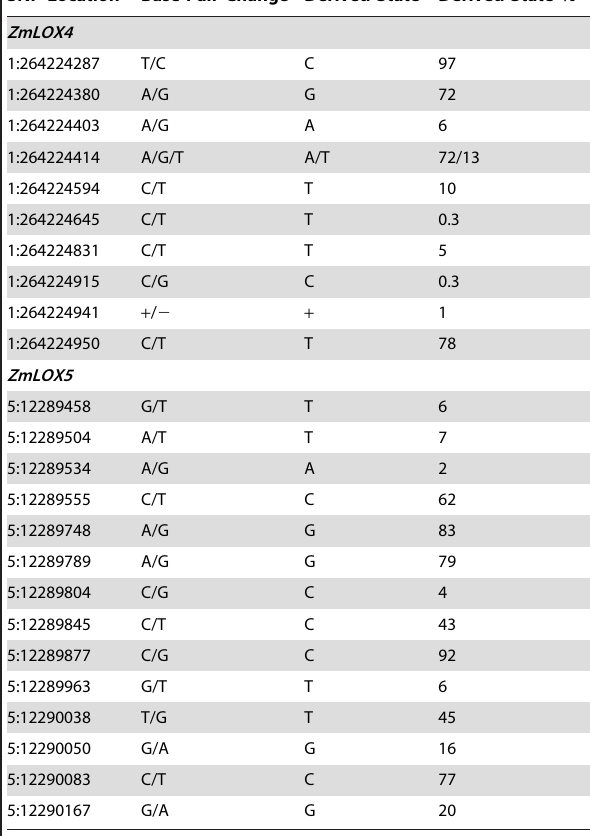
Table 1. SNP locations per B73 RefGen_v2 and their derived state percentages.